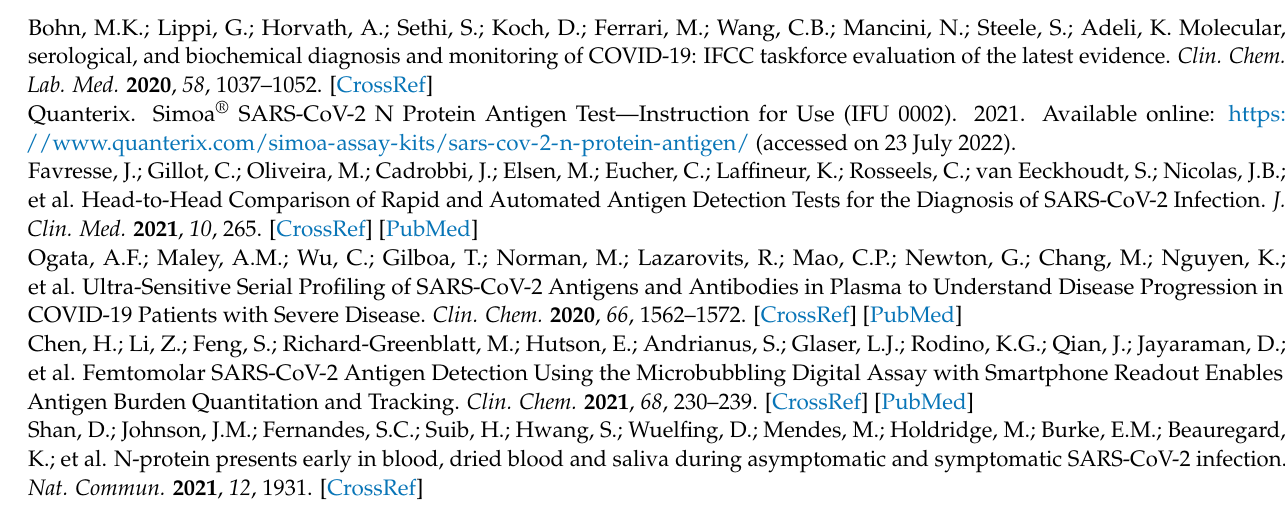
patient per disease category; Figure S2: ROC curves for cut-off determinations according to different sample inclusion settings; Figure S3: Correlation between the Simoa and the iFlash N antigen assays; Figure S4: Kinetics of antigenemia and SARS-CoV-2 Spike IgG antibodies since the onset of symptoms in non-severe and severe patients determined according to the WHO clinical progression scale; Figure S5: SARS-CoV-2 Spike IgG results in serum in severe versus non-severe patients. The grey dotted lines on the Y-axis correspond to the positivity cut-off of the assay; Table S1: Demographic data of the included population; Table S2: Description of patients with discordant results between Simoa and